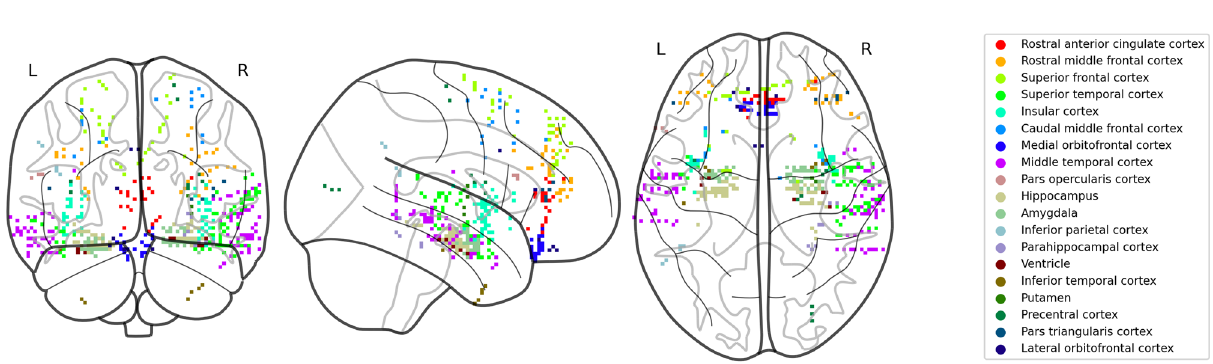
Figure 10. Number of sessions in which neural responses to note onsets and phrase boundaries are significantly different at − 149 , 0, 200, 450 ms relative to the stimulus markers .